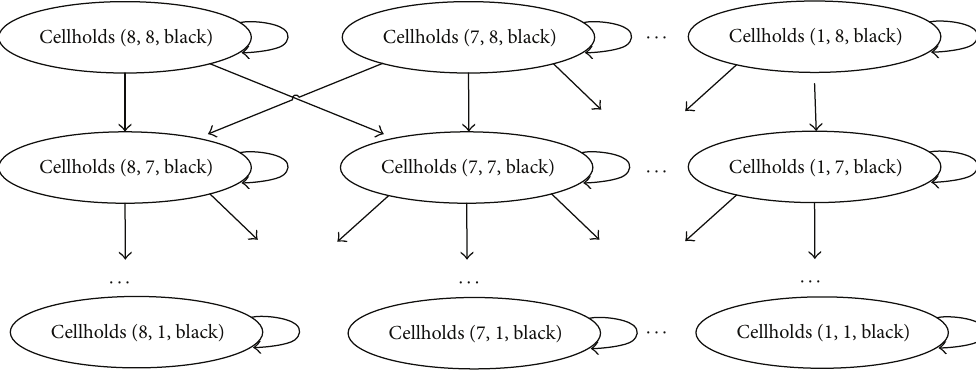
Figure 3: Distances between fluents in Breakthrough. The figure was reproduced based on